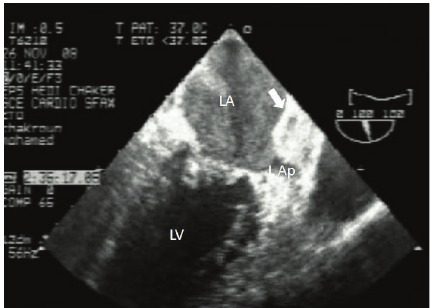
Figure 2: Transesophageal echocardiography showing an impor- tant spontaneous contrast and a large mass (white arrow) in both left atrium and appendage (LA: left atrium; LV: left ventricle; L Ap: Left appendage).